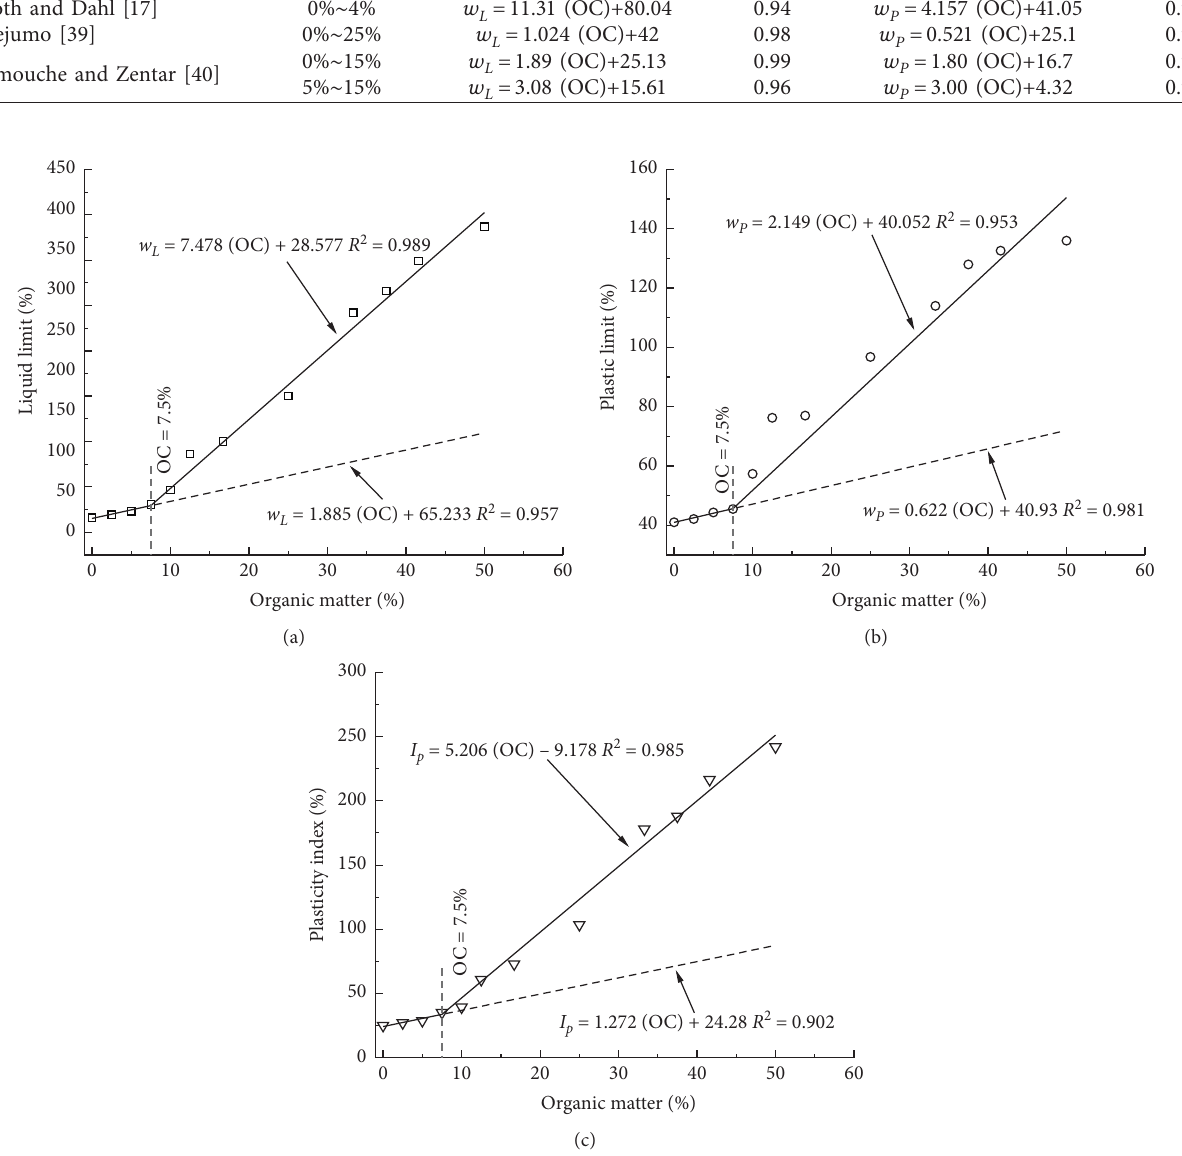
Figure 7: Change of Atterberg limit against organic content: (a) liquid limit, (b) plastic limit, and (c) plasticity